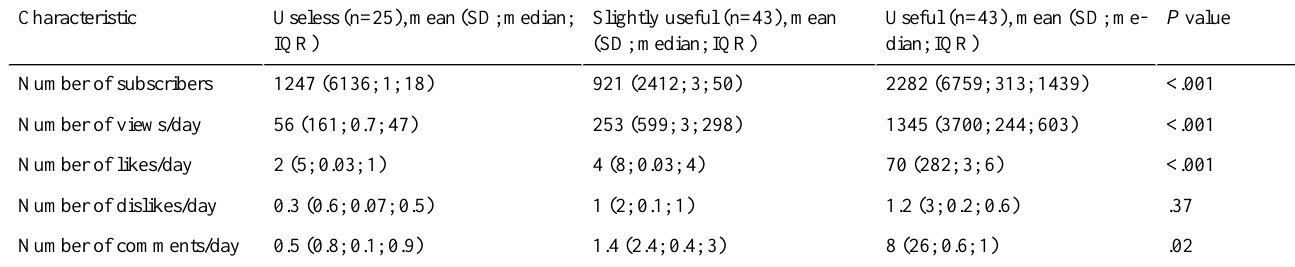
Table 2. Detailed characteristics of videos based on